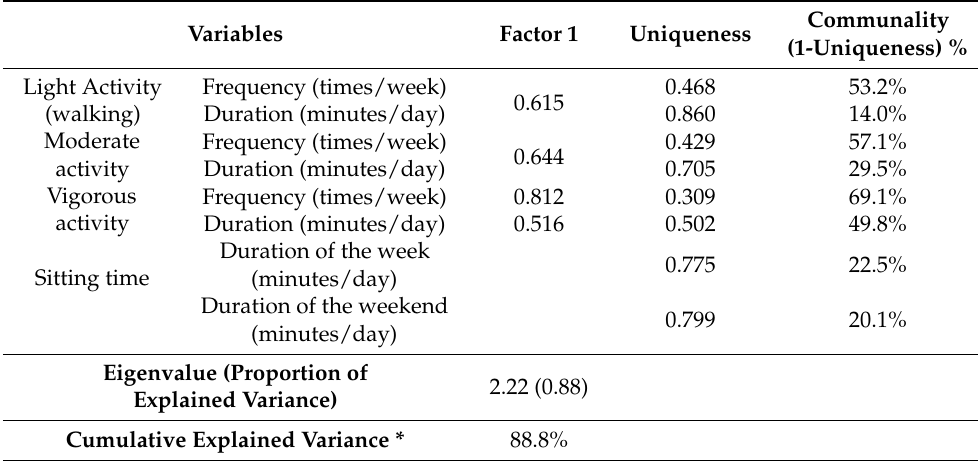
Table 3. Exploratory factor analysis of the International Physical Activity Questionnaire short form (IPAQ-SF).